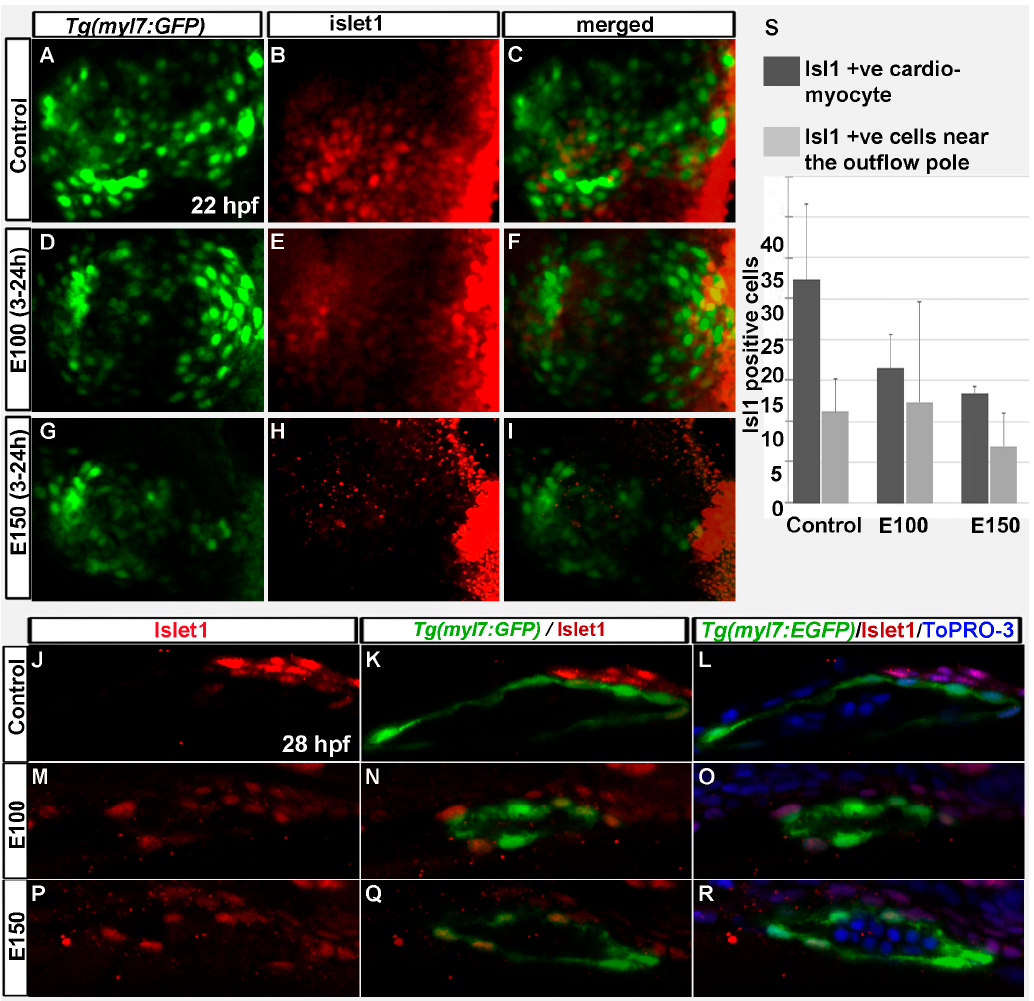
Figure 4. Embryonic ethanol exposure reduced second heart field precursors. ( A – I ) Anti-Islet1 antibody stained Tg ( myl7 : GFP ) embryos showed Islet1 positive second heart field precursors in the rotating heart cone in control embryos ( A – C ) at 22 hpf; ethanol exposed embryos showed reduced number of Islet1 positive cells in the heart cones ( D – I ) at 22 hpf; ( J – R ) Anti-Islet1 antibody stained Tg ( myl7 : GFP ) embryos showed second heart field derived cardiomyoctes in the heart (Myl7 and Islet1 double positive; red and green) and second heart field precursors (Islet1 positive, red) near the out flow pole in the control embryos ( J – L ) and ethanol-exposed embryos ( M – R ) at 28 hpf; ( S ) Graph shows the quantification of the Islet1/Myl7 double positive cardiomyocytes in the heart tube and Islet1 positive cells near the outflow pole at 28 hpf.